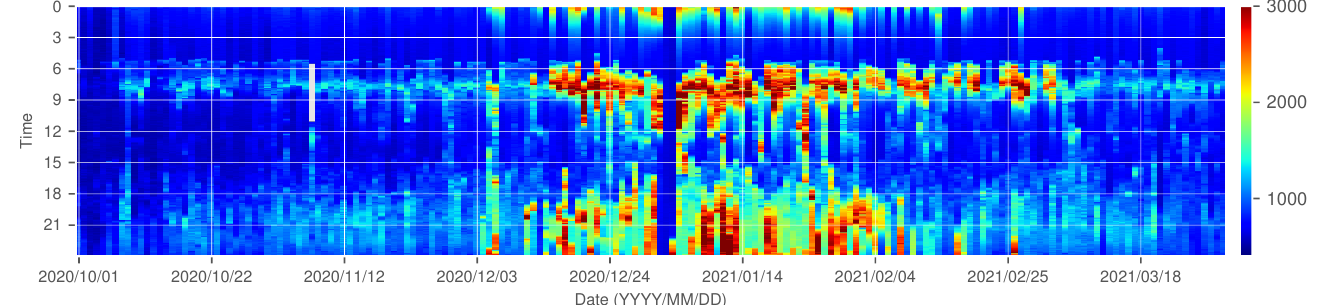
Figure 9. The heatmap of CO 2 concentration at ID